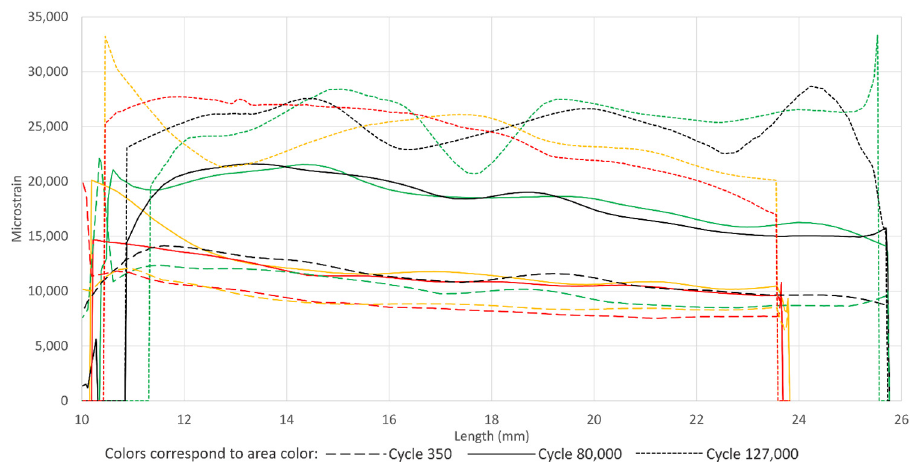
Figure 17. Hoop strain contour plot around the hole at cycle 127,768, shortly before catastrophic failure. The four rectangles highlight the four strain concentrations around the hole.